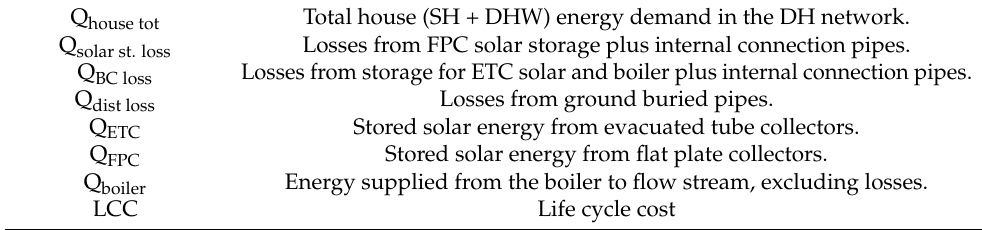
Table 9. KPI—overview over key performance indicators used in this study.